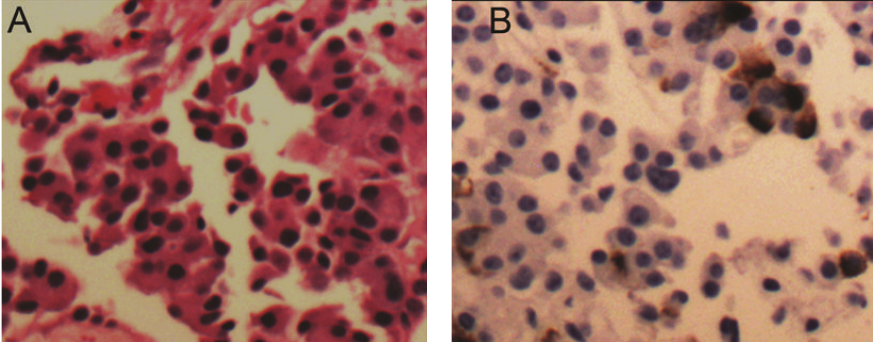
Figure 5: Core biopsy of liver, showing metastatic neuroendocrine carcinoma ( × 10 obj). (A) Hematoxylin/Eosin. (B) Biopsy showing focal positivity for